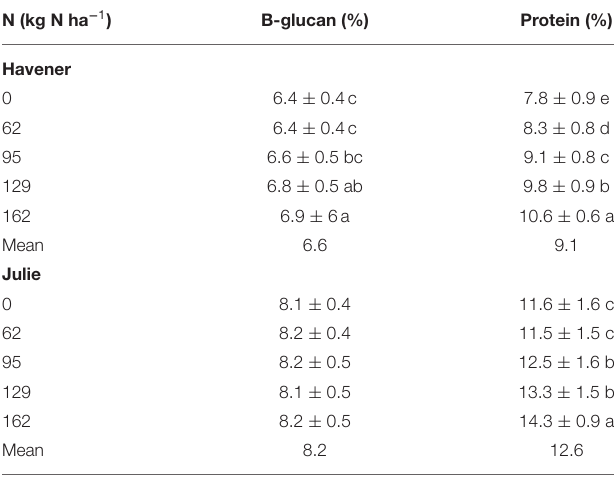
TABLE 13 | Effect of N rate on β -glucan and protein content of barley varieties Havener and Julie across all sites and years. N (kg N ha − 1